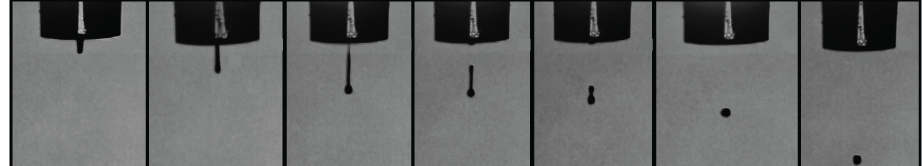
Figure 5. Droplet formation sequence for PEGDA-based bioink with a W PEGDA of 30% and loaded with spironolactone at a concentration of 20 mg/mL. This formulation had a Z value of 10.52, falling within the printable range (4–14).